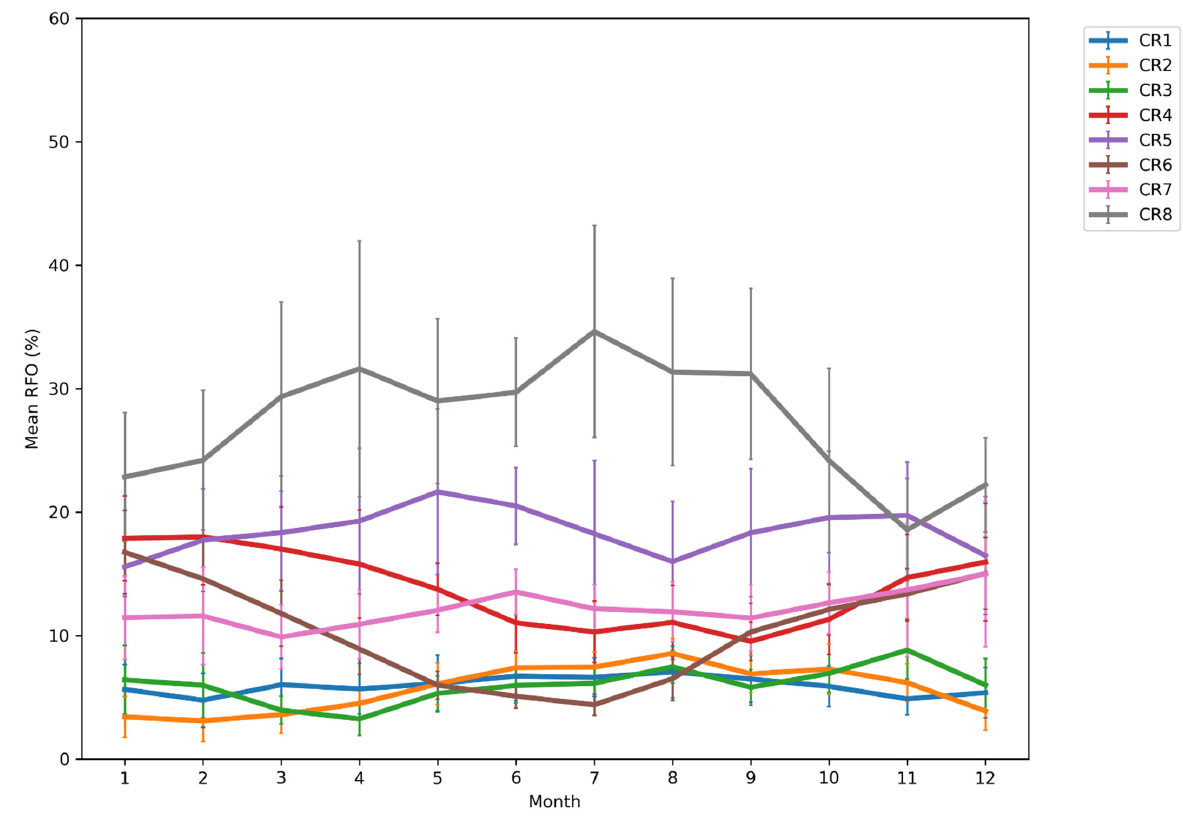
Figure 9. Similar to Figure 4 but for the region of Germany.